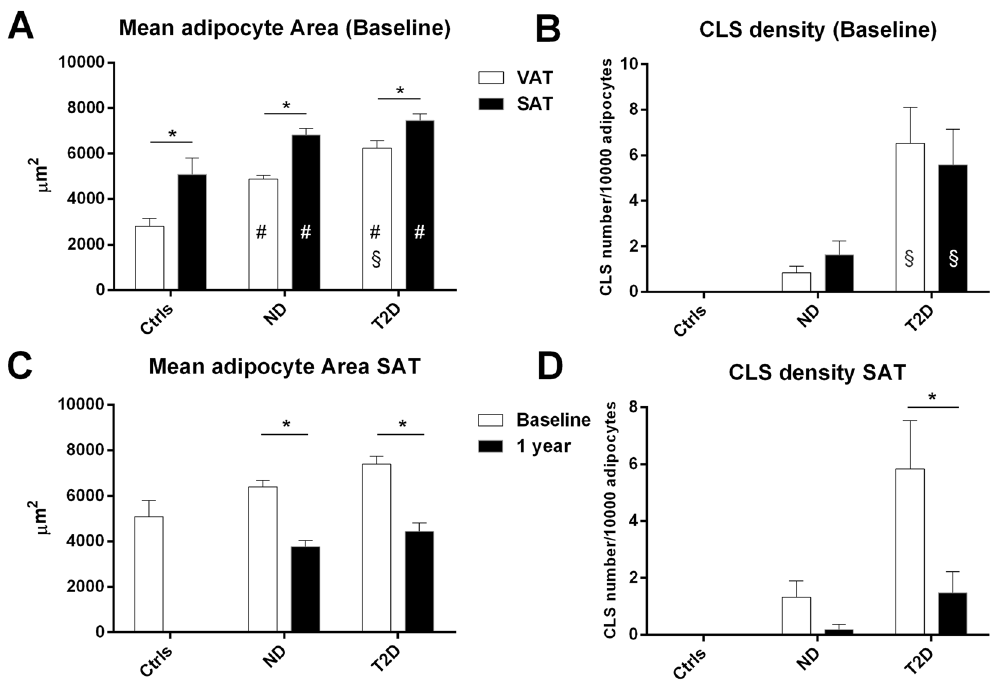
Figure 2. Mean adipocyte area ( A ) and crown-like structure density (CLS number/104 adipocytes, ( B )) from lean controls (Ctrls), ND and T2D patient biopses of visceral (VAT) and subcutaneous (SAT) depots before surgery (Baseline). In C and D , the same parameters have been shown in subcutaneous adipose tissues from ND and T2D patient biopsies before (Baseline) and post-surgery (1 year after surgery). In ( A and B ) (#) p < 0.05 by Mann Whitney U test for comparison of ND and T2D vs Ctrls; (§) p < 0.05 by Mann Whitney U test for comparison of T2D vs ND; and ( * ) p < 0.05 by Wilcoxon sign rank test to compare VAT vs SAT in each group. In C and D ( * ) p < 0.05 for the changes at 1 year vs baseline by Wilcoxon sign rank